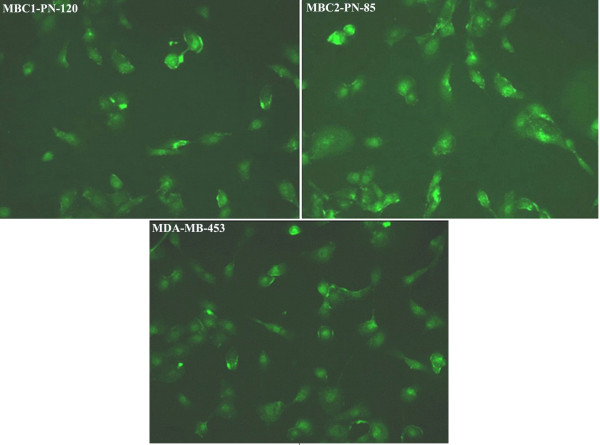
Expression of HER2 in MBC1 and MBC2 Cell Lines, with MDA-MB-453 as a Positive Control. The expression of HER2 with a localised staining pattern in the cell membranes was shown in the MBC1-PN-120, MBC2-PN-85 and MDA-MB-453(as a positive control). Magnification, 20X.